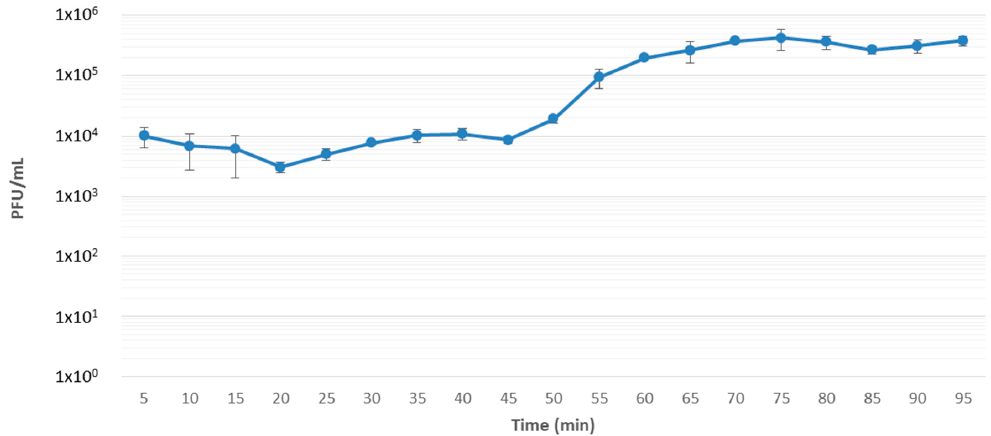
Figure 1. One-step growth curve of Pectobacterium phage vB_PatP_CB5 infection of host bacterium DSM 30186. Assay was independently repeated in triplicate and the results were averaged.